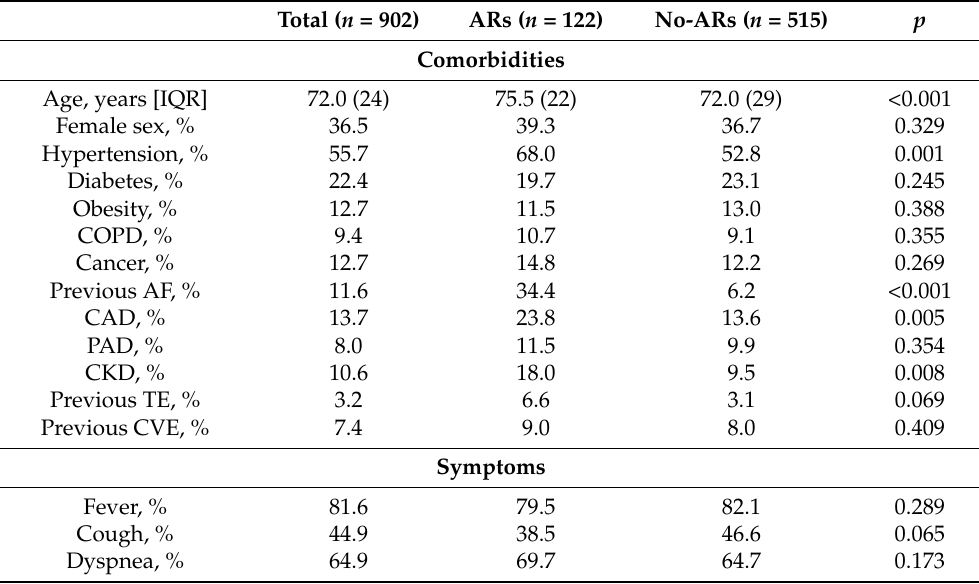
Table 1. Baseline